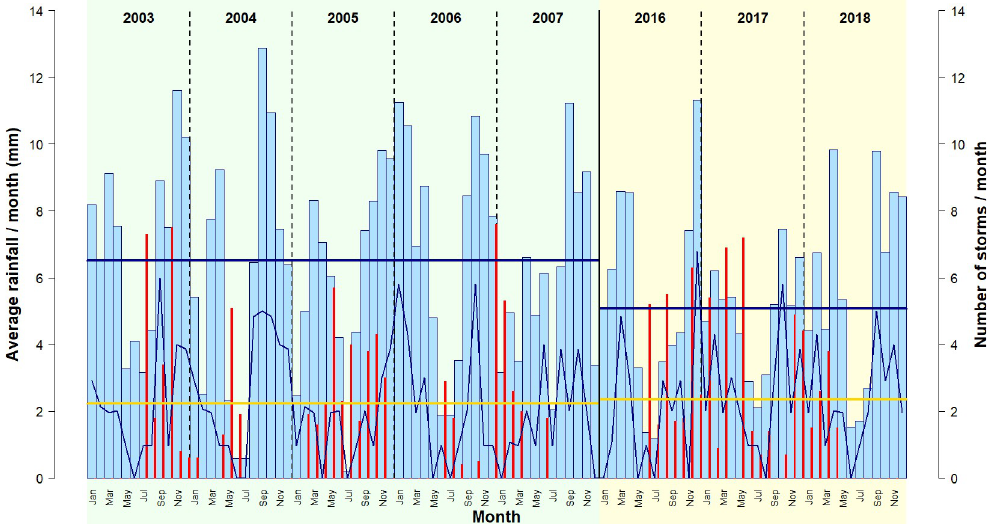
Fig 2. Monthly trend of average rain (light blue bars) and number of storms (dark blue line) across 1) periods (P1 = green background; P2 = yellow background), and 2) years (delimited by vertical lines). Horizontal solid lines represent 1) average monthly rainfall between periods (blue) and 2) average monthly number of storms between periods (yellow). Red vertical bars show the number of nests included in the study in each month (divided by 10, for graphical